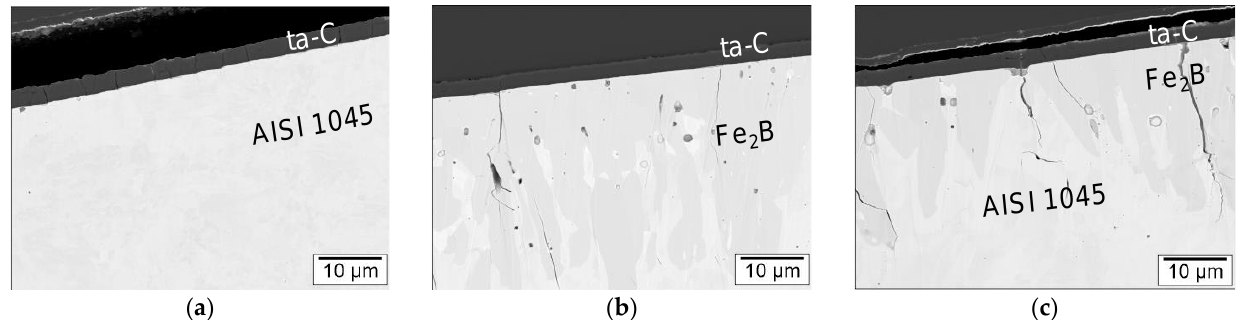
Figure 12. Pile-up of impact zones of samples exposed to 3 kN: ( a ) St-C after 10 5 load cycles; ( b ) St-B-C after 1 load cycle and ( c ) St-B-C after 10 5 load cycles.